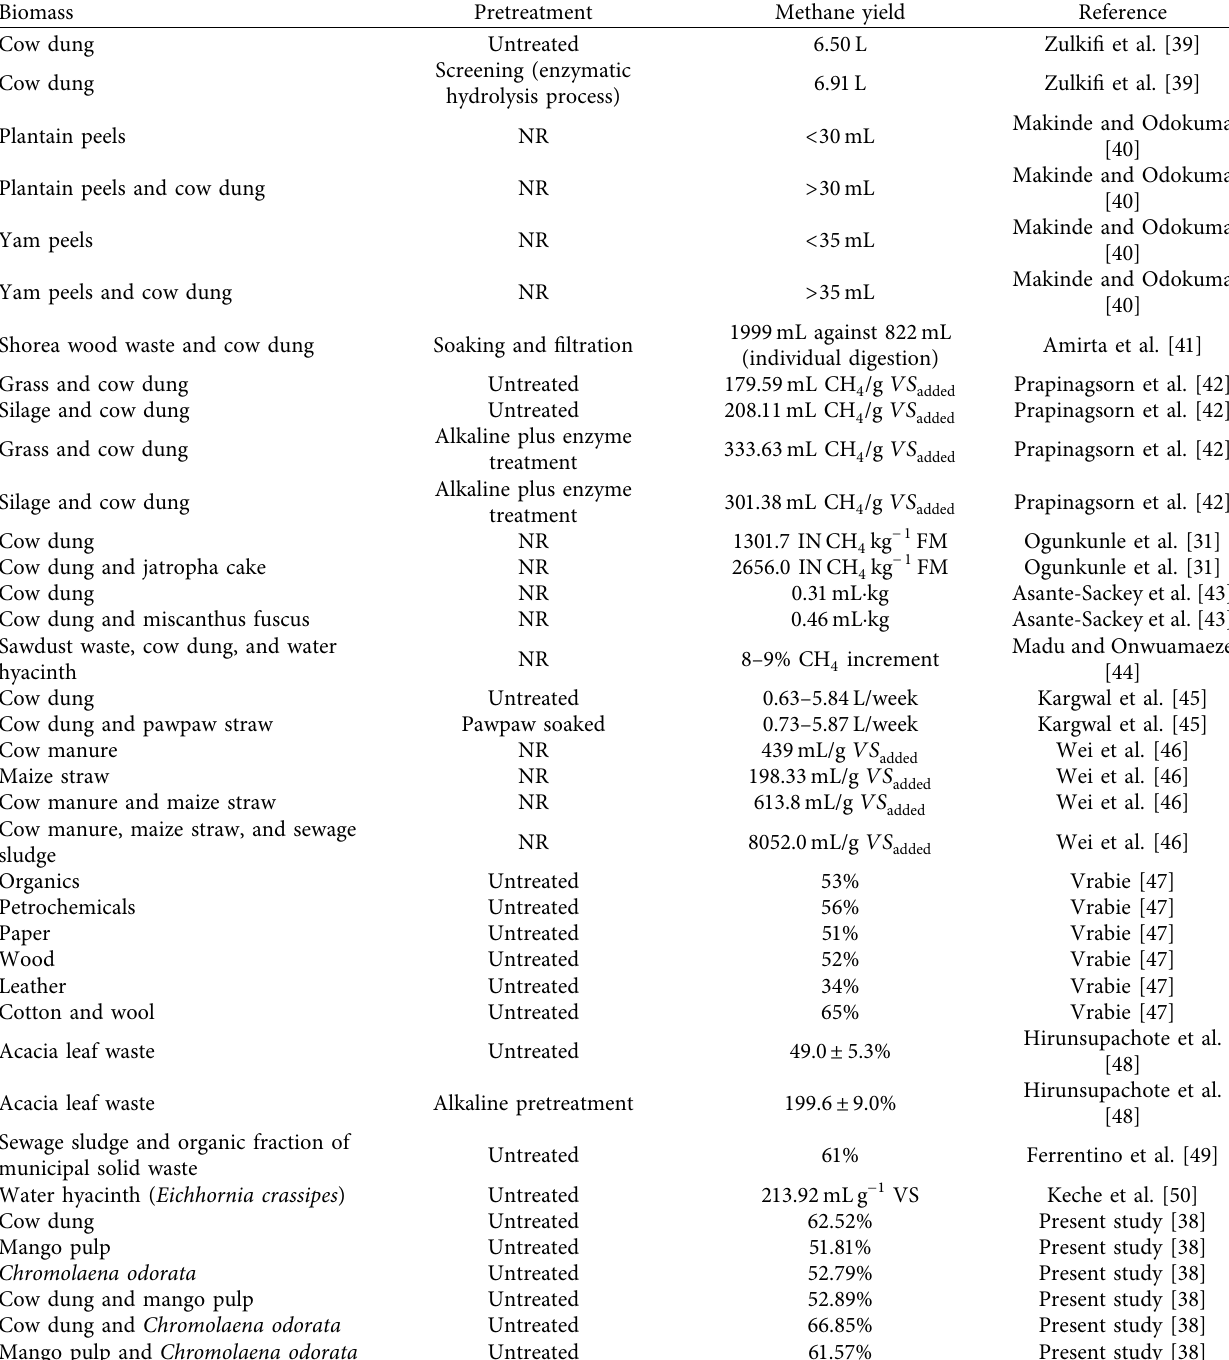
Table 4: Comparison of methane yield of previous and present